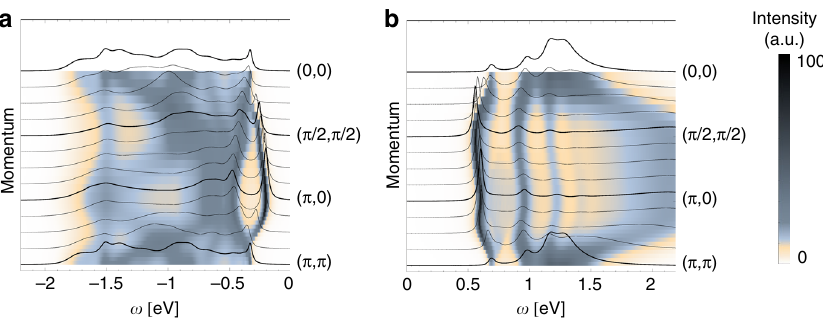
Fig. 2 Theoretical spectral functions of iridates. a Photoemission ( PES ) and b inverse photoemission (IPES) spectral function of the low-energy (polaronic) models developed for the quasi-two-dimensional iridates and solved using the self-consistent Born approximation (see text). Following parameters are used: spin exchange J 1 = 0.06 eV, J 2 = − 0.02 eV, J 2 = 0.015 eV, and spin-orbit coupling λ = 0.382eV following ref. 43 ; hopping integrals calculated as the